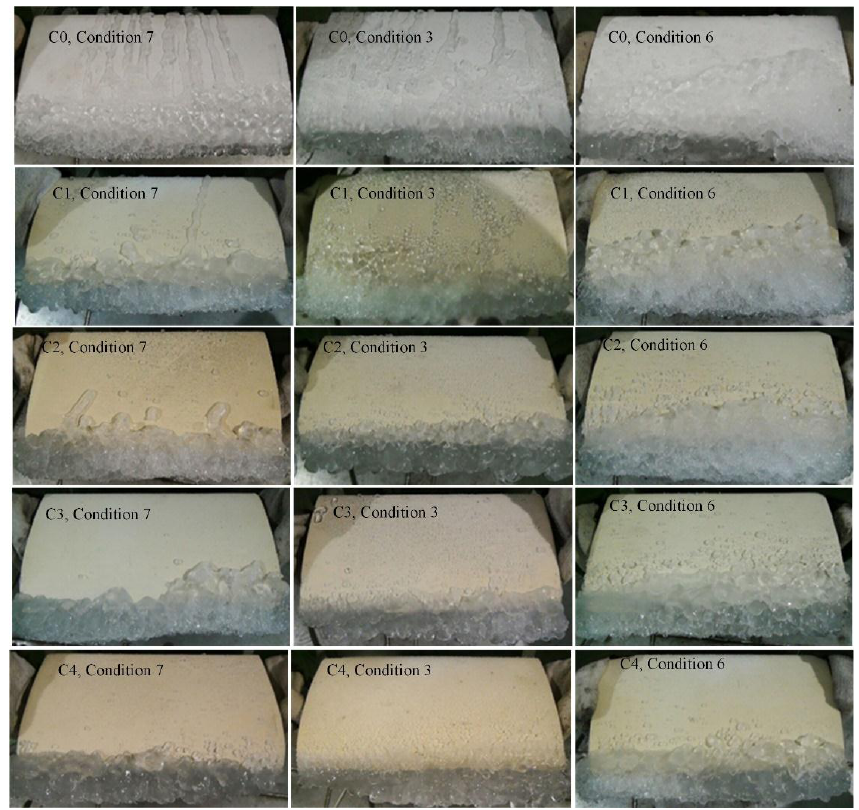
Figure 7. Ice morphology on blade sample under various conditions.